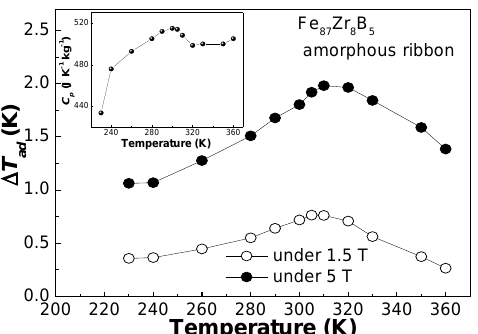
Figure 7. Δ T ad - T curve of the Fe 87 Zr 8 B 5 amorphous alloy under the fields of 1.5 T and 5 T, the inset is the C p ( T ) curve of the amorphous alloy.